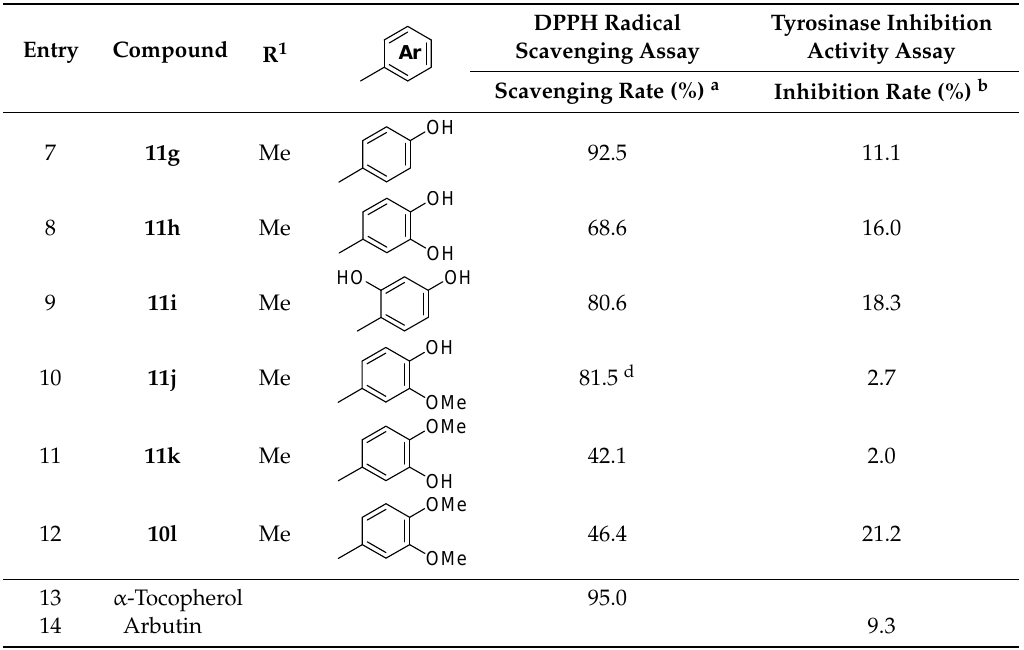
Table 3. The DPPH radical scavenging assay and tyrosinase inhibition activity assay of flavonols 11a – l .